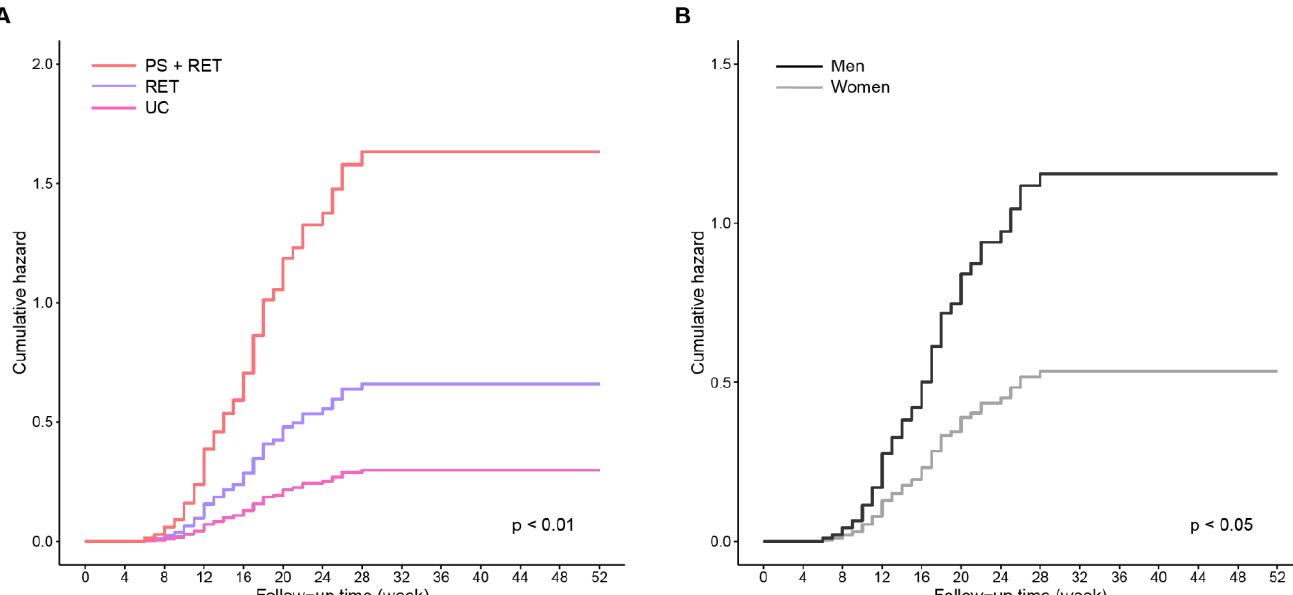
Figure 3. Cumulative hazard estimates of the likelihood of achieving normal walking speed according to ( A ) treatment group and ( B ) sex. All estimates are based on the results of the multivariate Cox proportional-hazards model with age, disease severity, comorbidity score, pain score, and walking speed at baseline used as covariates.